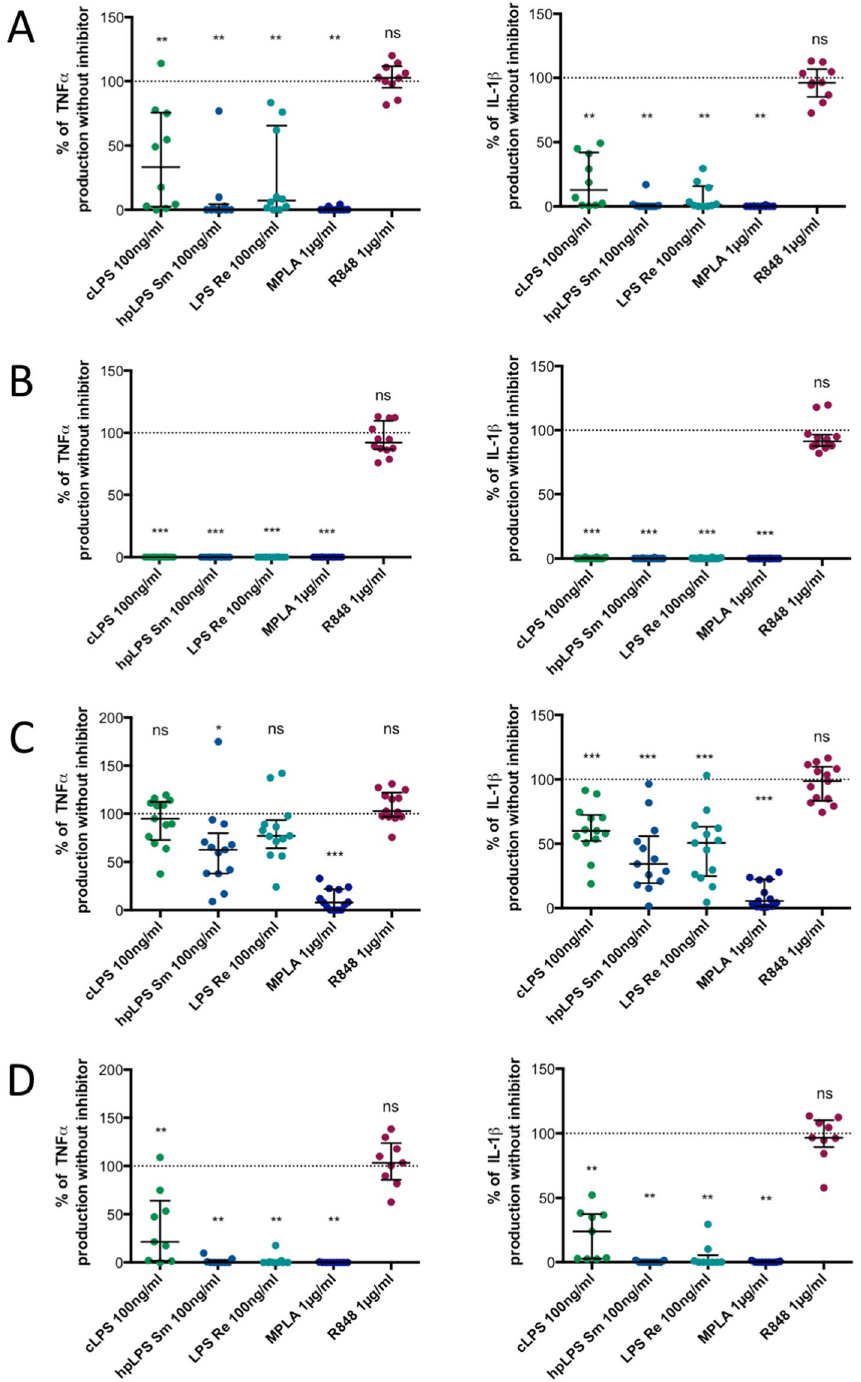
Figure 3. Both LPS and MPLA activate human adherent mononuclear cells via TLR4. ( A ) Inhibition by 1 µ g/ ml of Rhodobacter sphaeroides LPS of TNF and IL-1 β release induced by either conventional smooth E. coli O111:B4 LPS (cLPS) (100 ng/ml), highly purified S. abortus equi LPS (hpLPS) (100 ng/ml), highly purified rough S. minnesota LPS (ReLPS) (100 ng/ml) or MPLA (1 µ g/ml) for different donors. ( B ) Similar experiments performed with 10 µ g/ml of R. sphaeroides LPS. ( C ) Similar inhibitory experiments performed with 10 nM or ( D ) 100 nM Eritoran (each dot represents one individual donor). Neither Rhodobacter sphaeroides LPS nor Eritoran affected the cytokine production in the absence of agonists (data not shown). Results are expressed as percent of the individual responses in the absence of inhibitors. * p ≤ 0.5; ** p < 0.01; *** p <